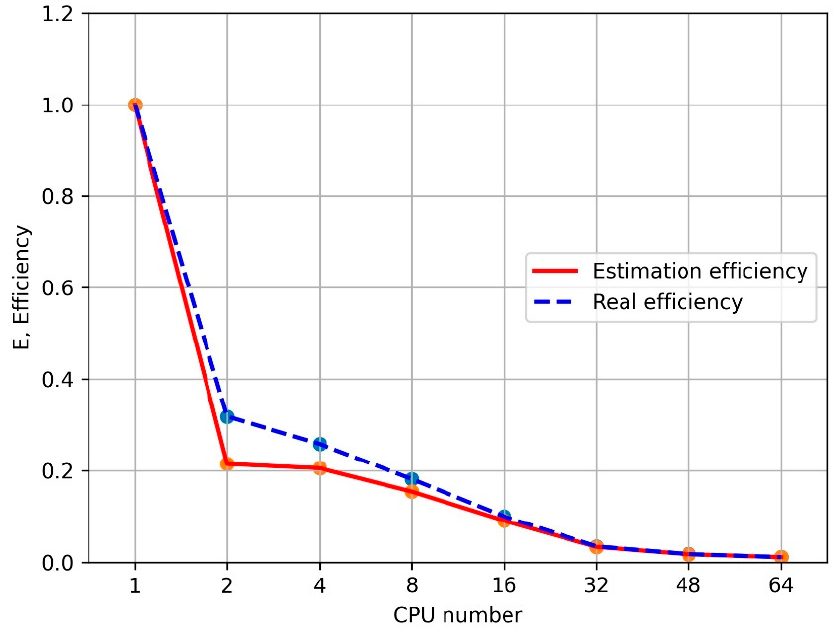
Figure 6. The efficiency of parallel implementation for the second block of calculations.